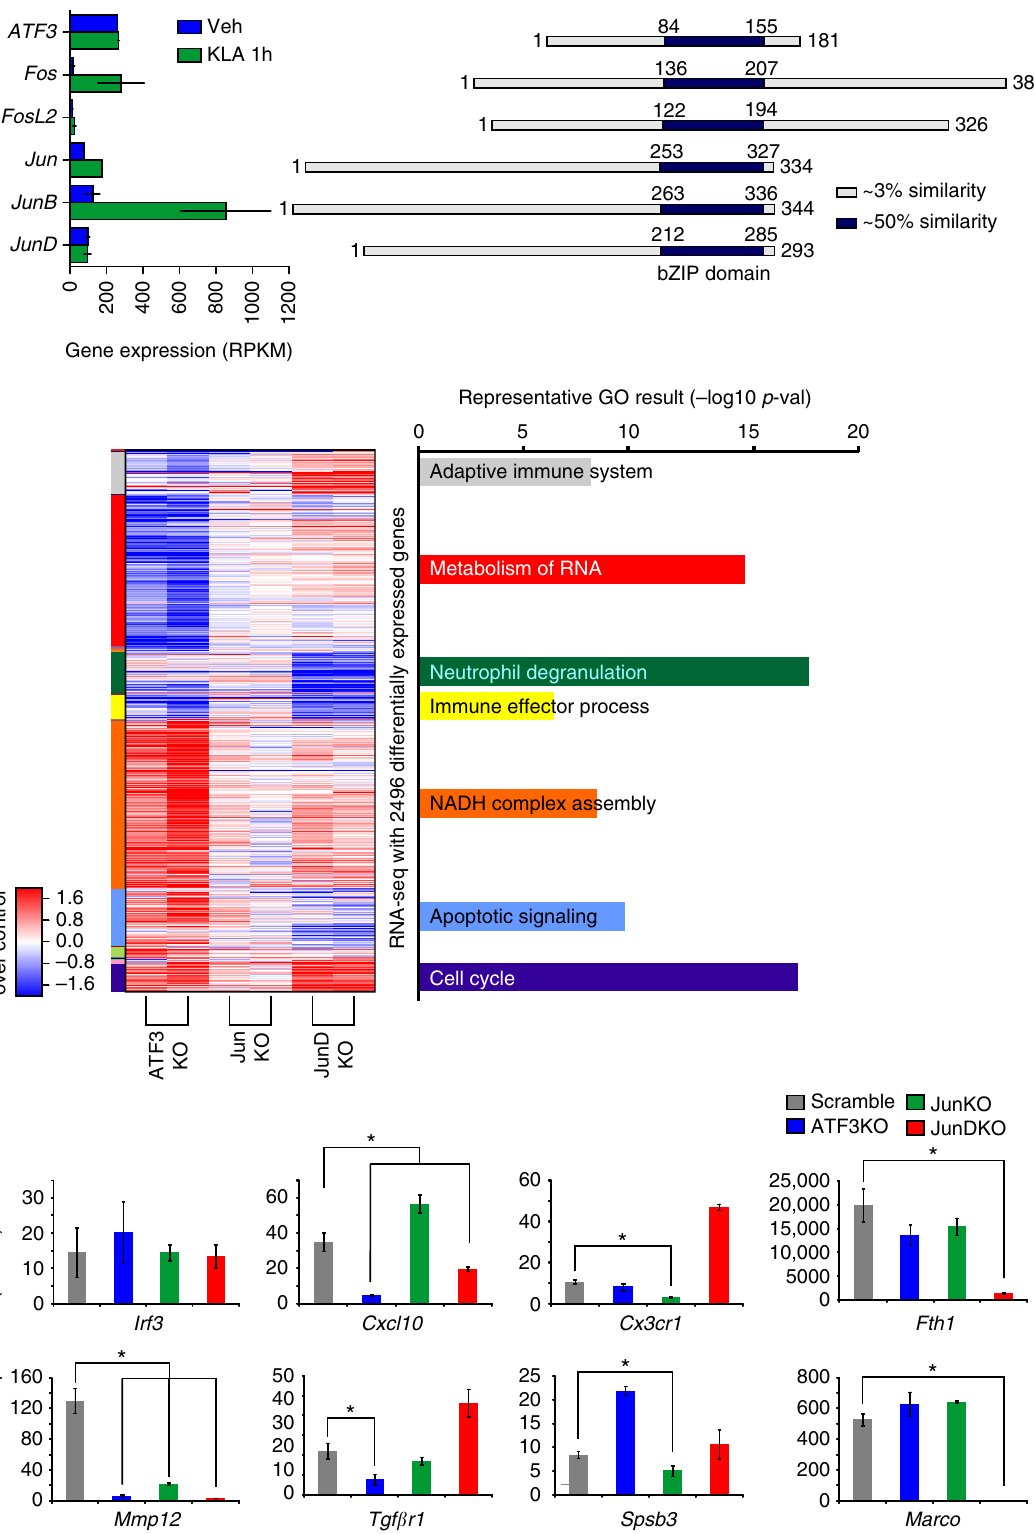
Fig. 1 AP-1 proteins have overlapping and distinct transcriptional functions in macrophages. a Protein alignment of monomers (right) and mRNA expression of monomers in thioglycollate elicited macrophages before and after 1-h Kdo2 lipid A treatment (left). b Hierarchical clustering of genes that are differentially expressed in immortalized bone marrow-derived macrophages subjected to CRISPR-mediated knockdown of the indicated AP-1 monomer with respect to scramble control. Expression values are given as the fold change with respect to scramble; values are Z -score normalized across each row. Representative functional annotations for each gene cluster are calculated using Metascape and the enrichment of each term is quanti fi ed as the negative log transform of the p -value. c Expression of a subset of genes in AP-1 protein knockouts. n = 2. End points of the error bars indicate the value from each replicate. * indicates False discovery rate (FDR) <